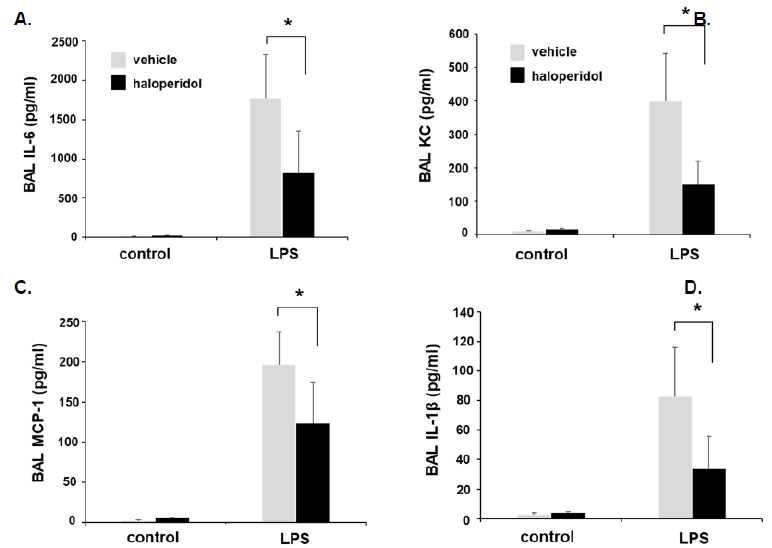
Figure 6. Murine ALI is attenuated by haloperidol: BAL fluid cytokines. Mice were pretreated with haloperidol (4 mg/kg, IP) or vehicle 24 h prior to repeat treatment of the same followed by the administration of intratracheal LPS (1.25 mg/kg). BAL fluid was collected 24 h later and assessed for inflammatory cytokines including ( A ) IL-6, ( B ) KC, ( C ) MCP-1, and ( D ) IL-1 β . ( n = 5/LPS groups, * p < 0.05).